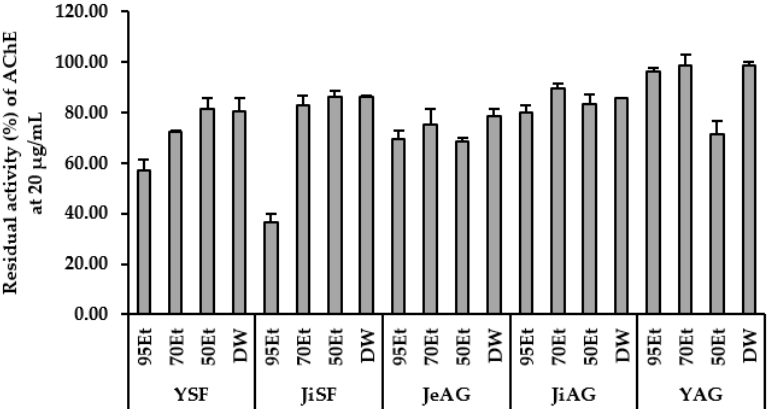
Figure 4. Inhibition of AChE by the extracts. Activity of AChE was observed by Ellman method as described in the ‘Materials and Methods’ section, by adding the extract ( 20 μg/mL ) to the reaction mixture containing ATCI and DTNB (0.5 mM each).